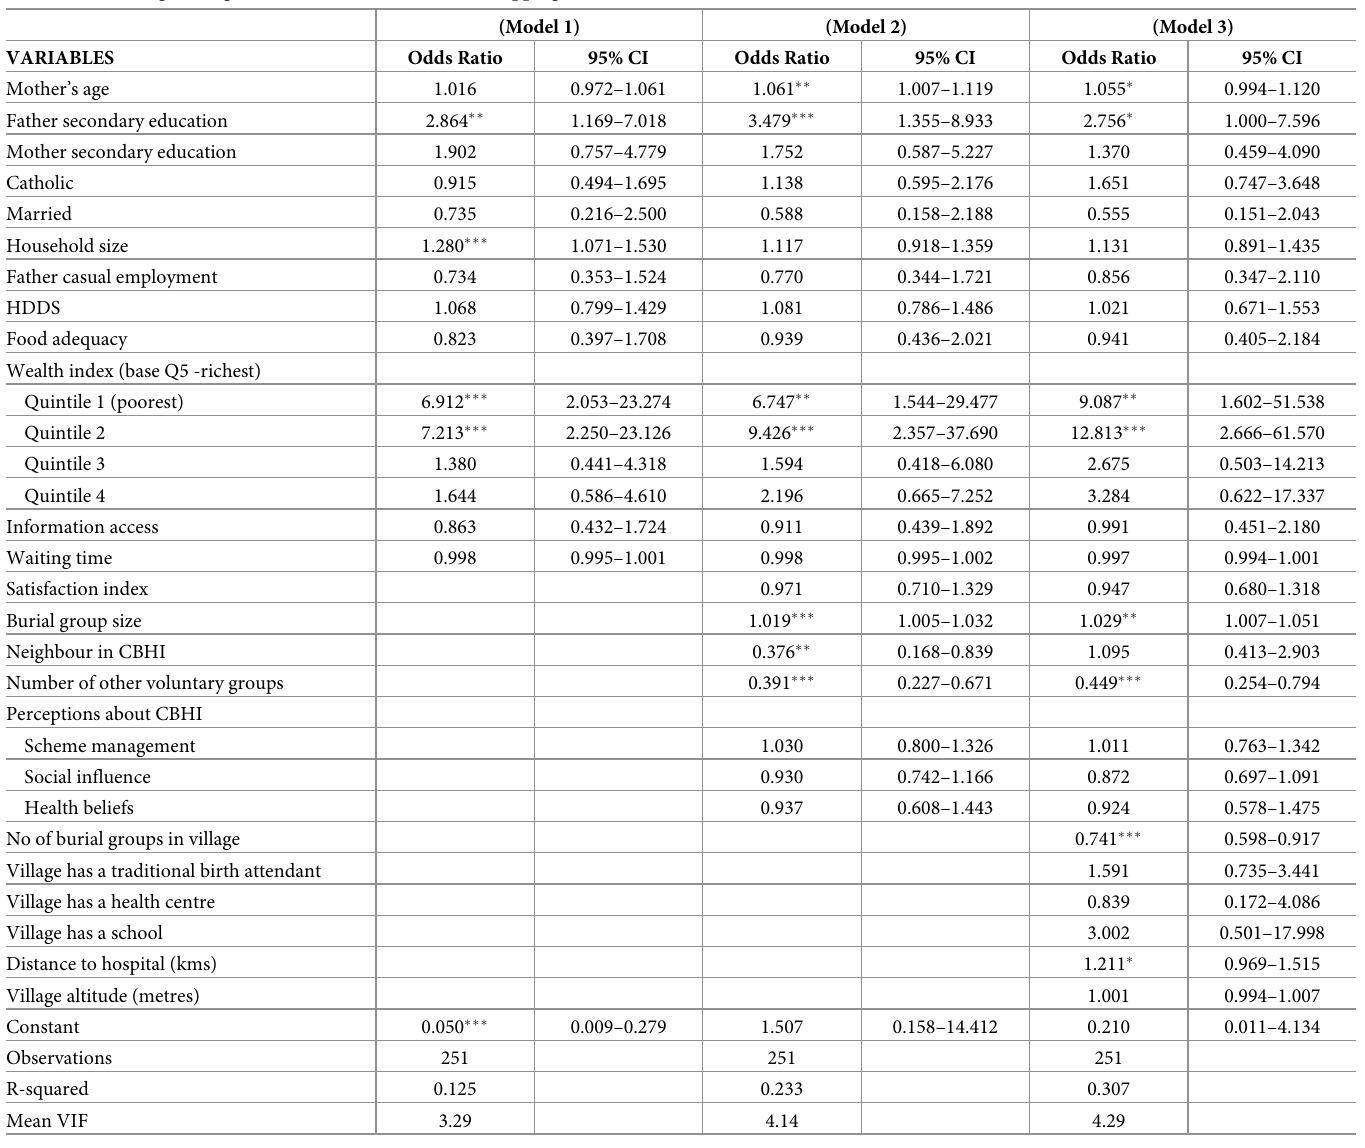
Table 2. Nested logistic regression results of correlates of dropping out of